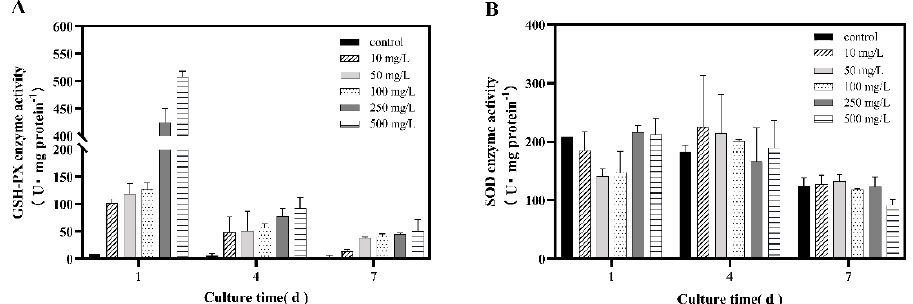
Figure 3. Effect of different selenite concentrations on antioxidant enzyme activities. ( A ) Effect of different selenite concentrations on GSH-PX enzyme activities. ( B ) Effect of different selenite concentrations on SOD enzyme activities.